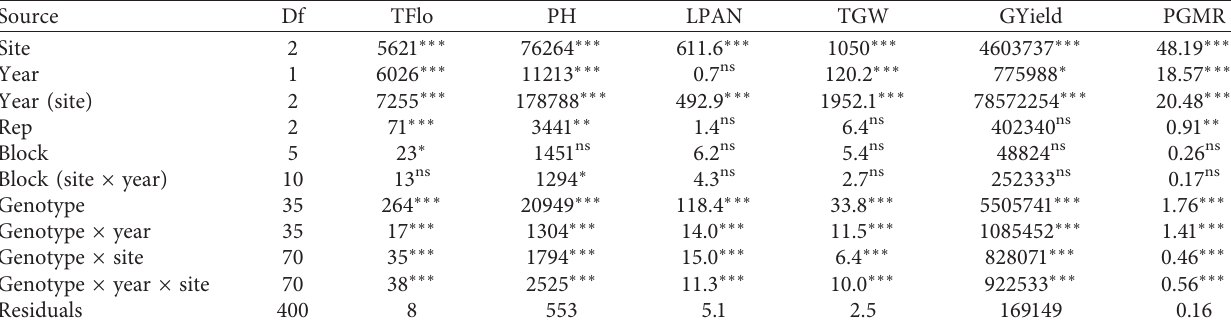
Table 2: Mean squares ANOVA for six measured traits of sorghum parental lines and their hybrids evaluated at three sites in Senegal in 2015 and